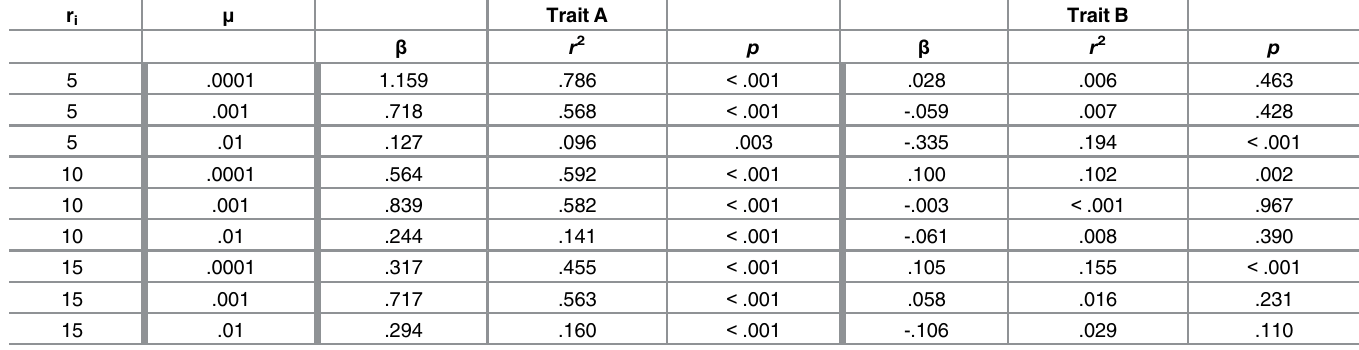
Table 5. Results of regressing t F on r e for d =